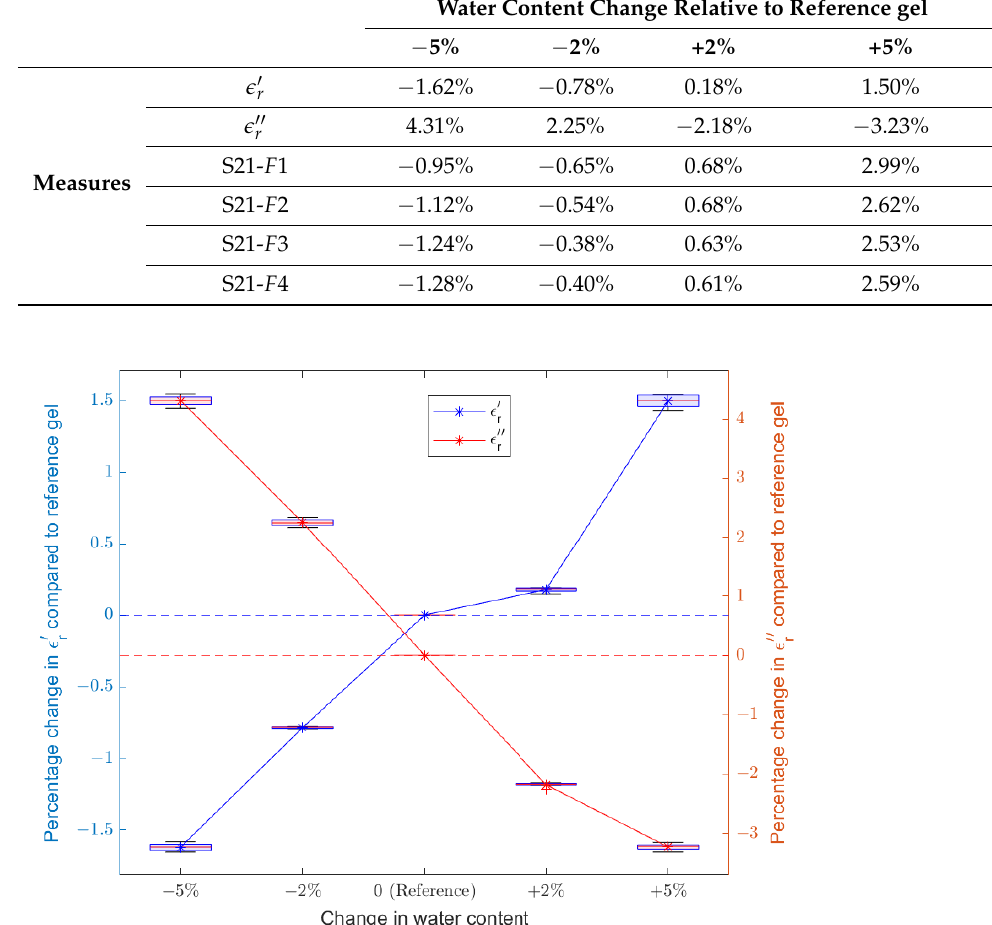
Figure 2. Plot of changes in dielectric properties of agar phantom gels with increasing water